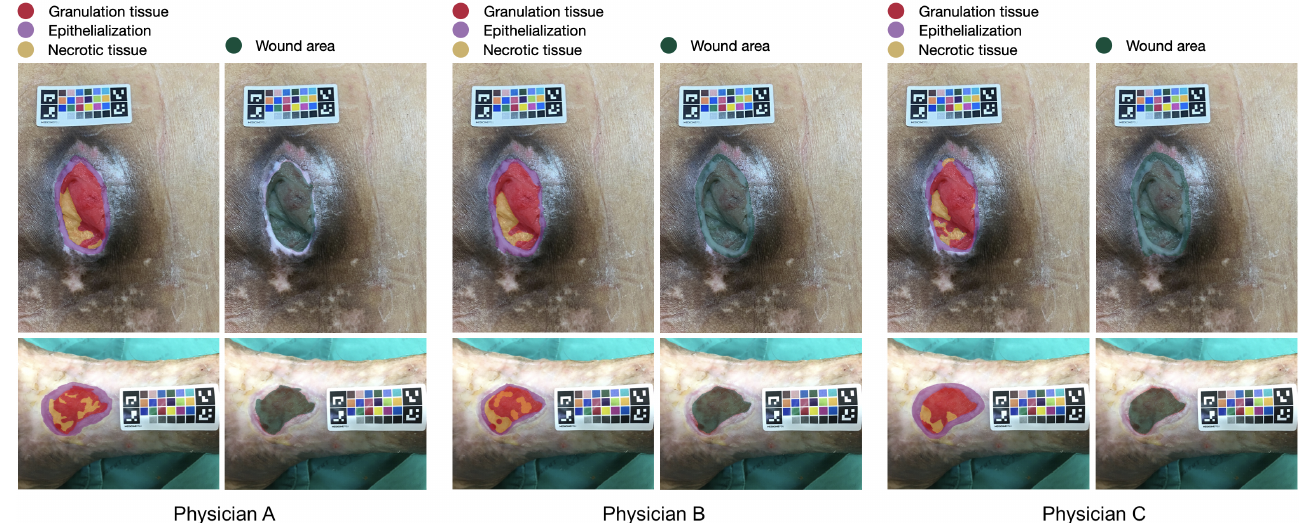
Figure 3. Example of a wound image labeled by three different physicians with the calibration chart positioned near the wound for color and measurement calibration. The red, orange, purple, yellow, and blue colors represent granulation tissue, necrotic tissue, epithelialization area, and wound area, re- spectively. Despite the use of clear guidelines and standards for labeling, slight differences in the areas annotated by the three physicians were observed. These differences may be due to a range of factors, including the physicians’ training, experience, and personal approaches to image